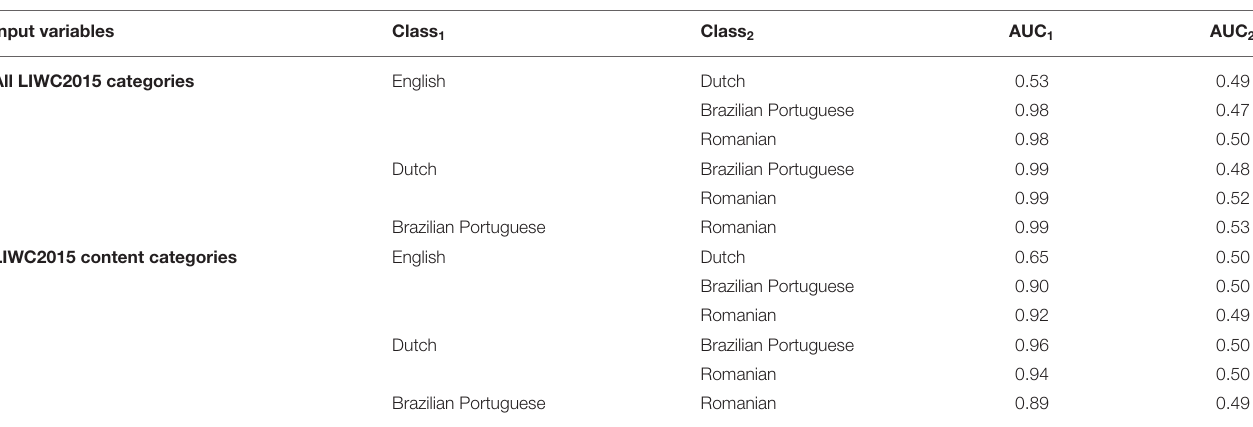
TABLE 5 | The AUC for the binary